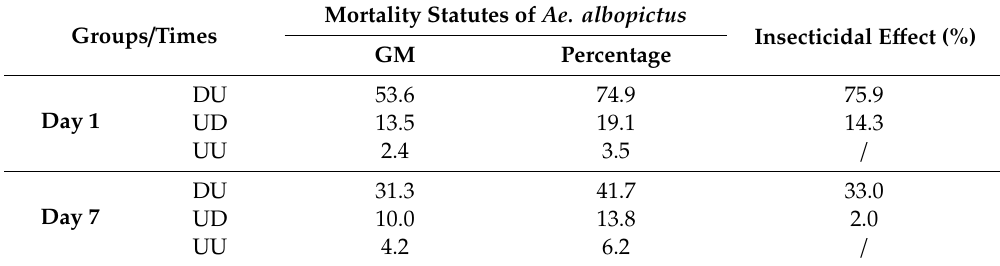
Table 3. Insecticidal e ffi cacy of Vectra ® 3D against Ae. albopictus in combined mouse–rat model at 2 h post-exposure.